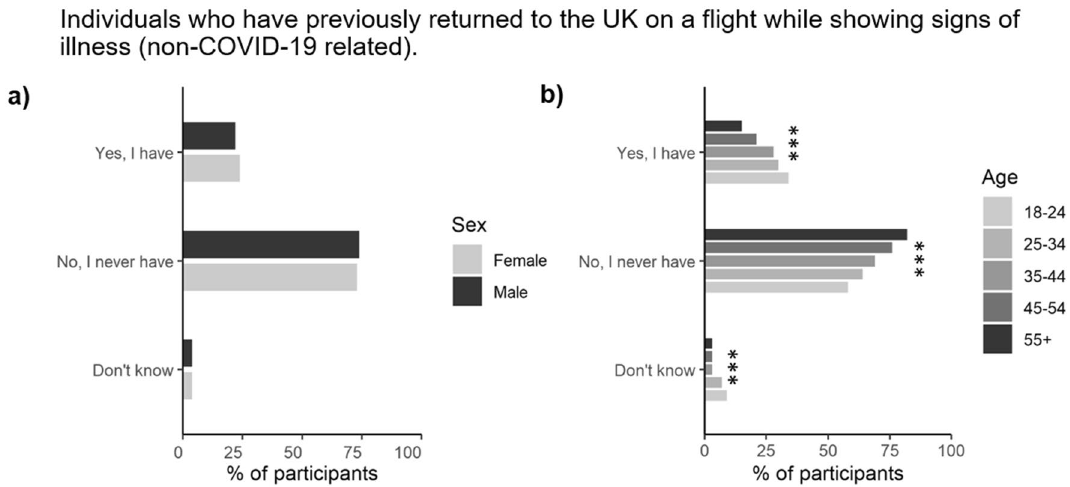
Figure 4. Proportion of participants stratified by either ( a ) gender, or ( b ) age ( n = 2103). *, **, and *** represent significant differences between the gender or age categories for a particular symptom at the P < 0.05, P < 0.01 or P < 0.001 level, respectively.